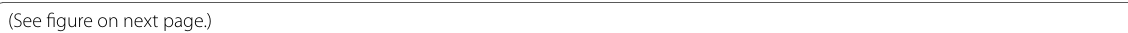
figure on next Fig. 3 a CBCT cut showing the chosen virtual planning for a zygomatic implant in a maxilla classified as ZAGA type 0. The finding of adequate alveolar dimensions together with a flat maxillary wall converts the intra‑sinus implant path into the first election. b Clinical picture illustrating the “tunnel type” osteotomy entrance and the external pencil guideline that has been drawn previously to the osteotomy. c Occlusal clinical picture illustrating the final position of the Straumann ZAGA‑Round implant head, totally closing the circular osteotomy. d CBCT cut after one year of implant placement. Implant stability together with implant neck osseointegration into adequate bone architecture is interpreted as the reason for long‑term sinus transparency maintenance. e Occlusal clinical picture showing soft tissue stability at one‑year follow‑up. The chosen intra‑sinus path in a maxilla presenting enough residual alveolar bone and a flat maxillary wall is not associated with soft tissue problems nor with non‑anatomic prostheses. (Patient treated in collaboration with Drs. Peter and Madalina Simon, ZAGA Center Stuttgart, Germany.) f Occlusal view of the provisional prostheses. Note the favorable emergence of the prosthetic